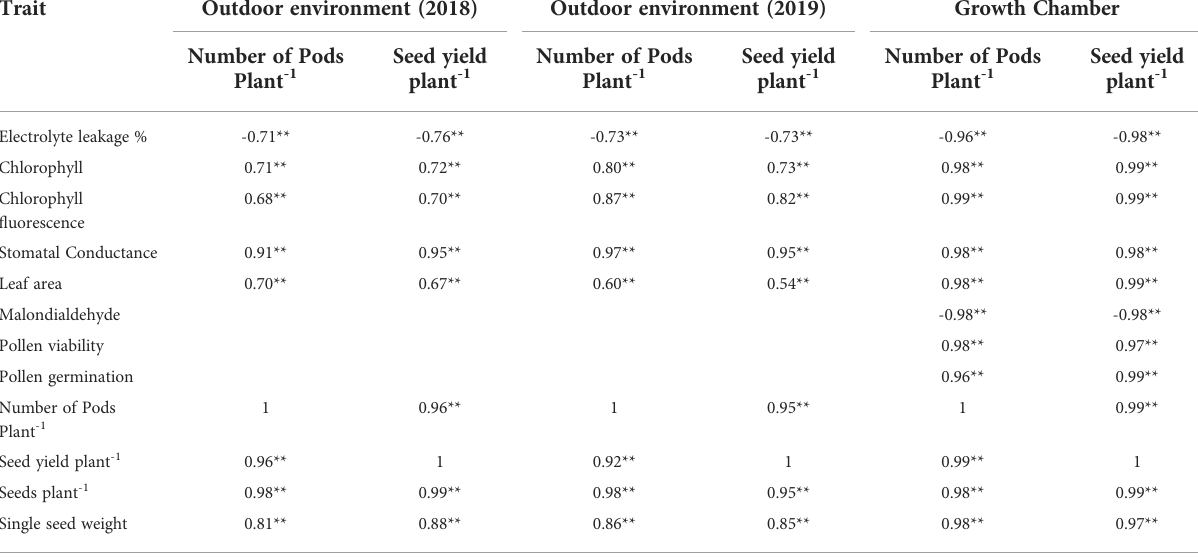
TABLE 2 Correlation coef fi cients of various traits with yield traits in plants under heat stress environment. Trait Outdoor environment (2018) Outdoor environment (2019) Growth Chamber Number of Pods Seed yield Number of Pods Seed yield Plant -1 plant -1 Plant -1 plant -1 Plant -1 plant